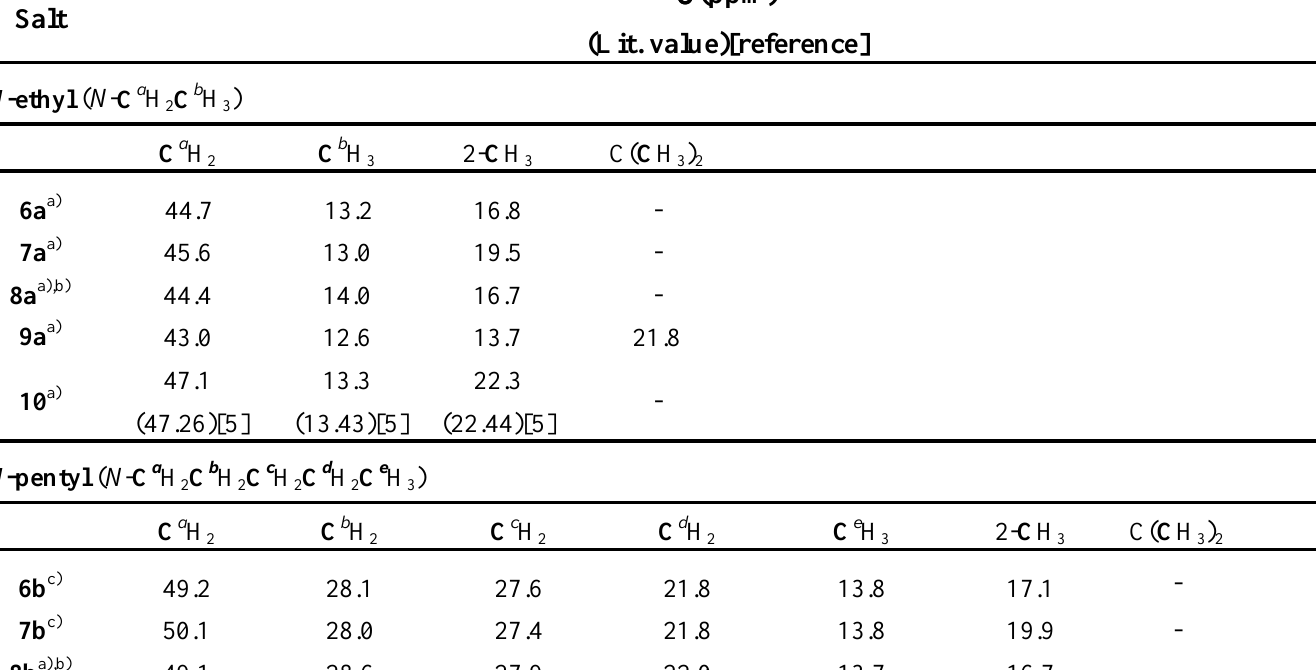
Table 4 . Aliphatic 13 C-NMR spectral data of quaternary ammonium salts 6 - 10 (DMSO-d Salt